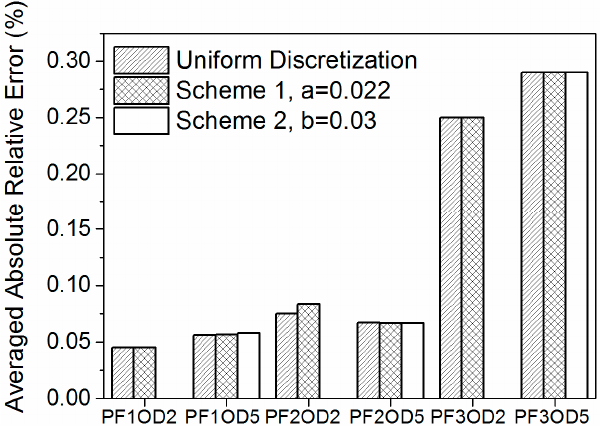
Figure 7. Averaged absolute relative error of Markov chain angular distribution predictions compared to Monte Carlo in different cases. Angular range was set to 0–30° (transmitted photons) and 150–180° (reflected photons).